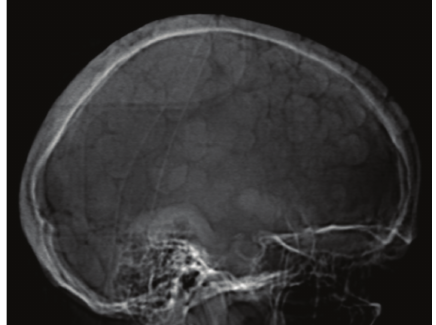
Figure 1: Skull radiograph, lateral view: multiple nodular densities overlie the calvarium.